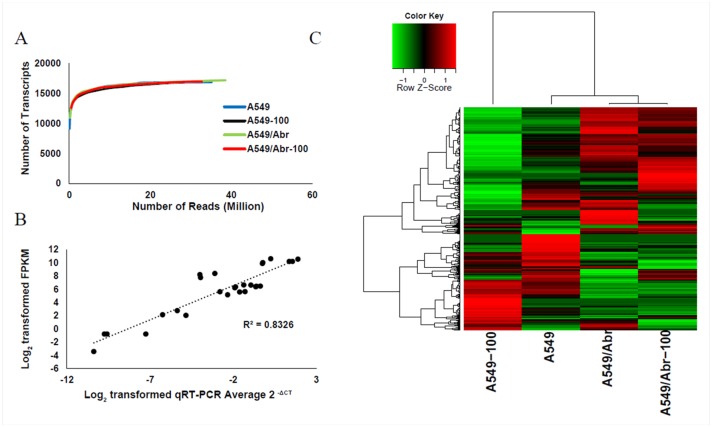
(A) Number of transcripts detected as a function of read depth. X-axis: number of reads (millions) mapped to the genome; Y-axis: the number of transcripts detected in genes from the National Center for Biotechnology Information (NCBI) database. (B) Correlation between qRT-PCR and RNA-Seq for selected genes in A549, A549-100, A549/Abr and A549/Abr-100 cells. The selected genes are ABCB1, ABCC1, ABCG2, MGST1, BCL2, BAX, TP53, ANXA2, HIF1A. (C) Cluster analysis of expressed genes in four cell types. Expression intensities are displayed from green (low expression) to red (high expression).